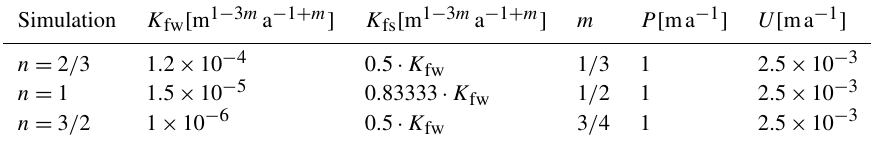
Table 2. Parameters used in the FastScape model runs.